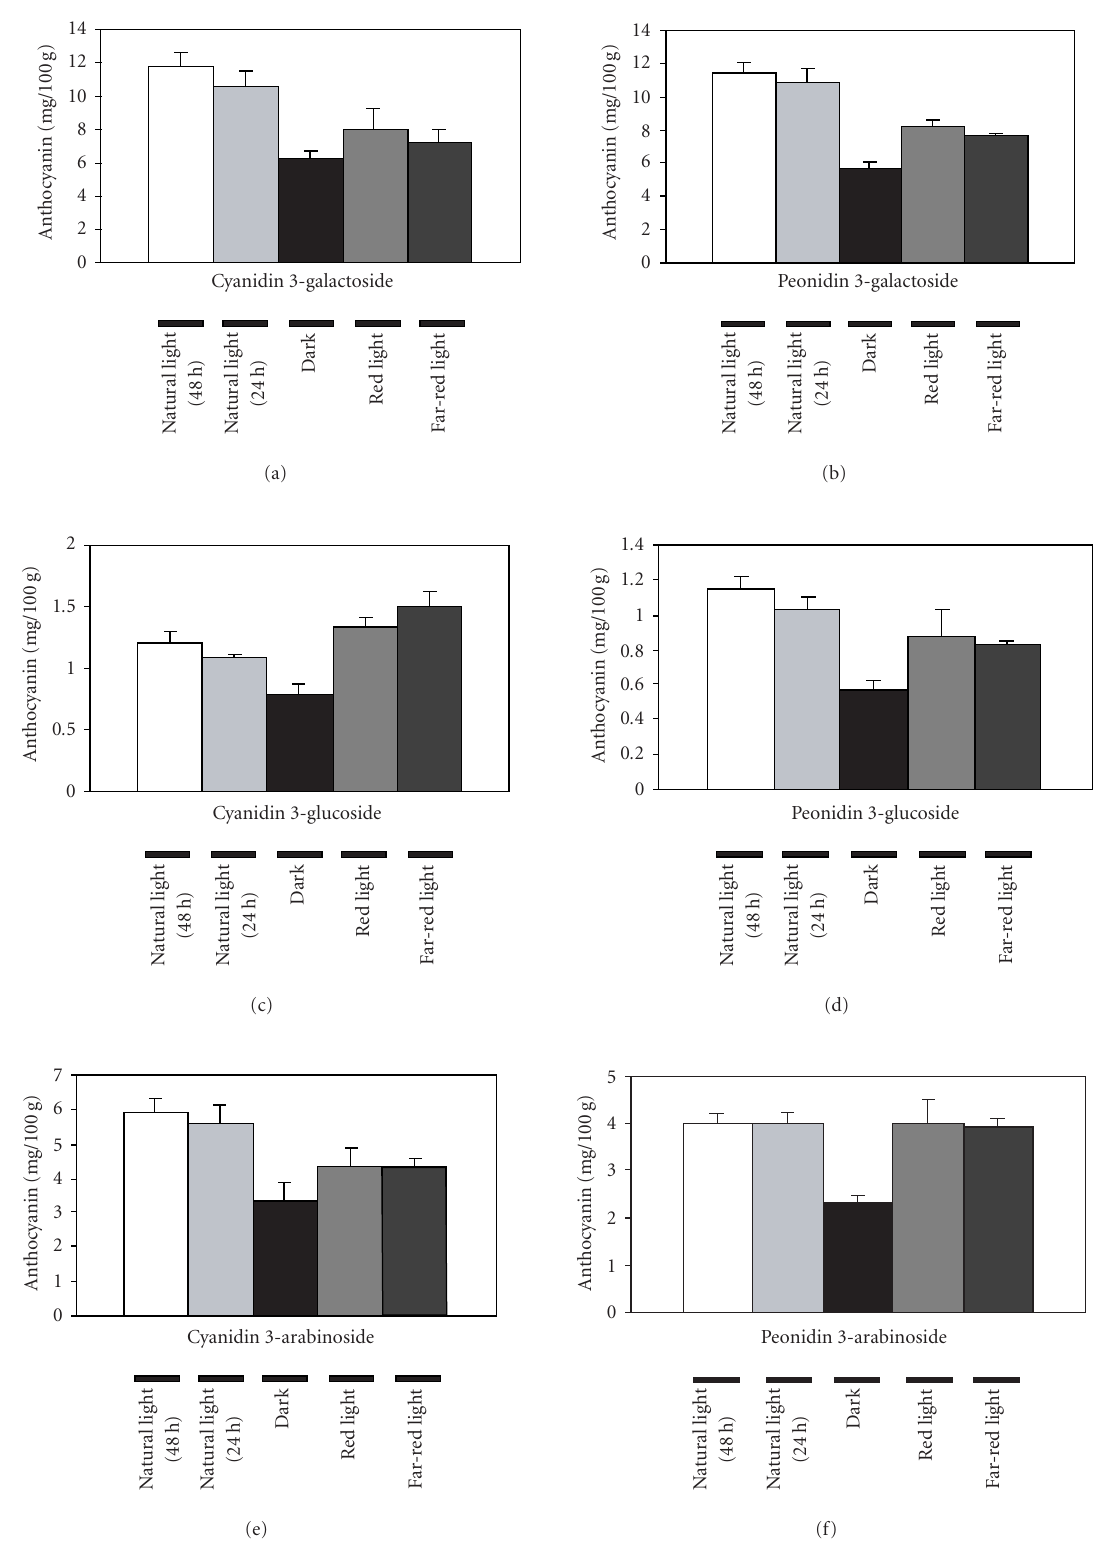
Figure 1. E ff ect of light on individual anthocyanin levels in submerged, harvested cranberry fruit. Cranberries were exposed to di ff erent light conditions and individual anthocyanin content was analyzed. Di ff erent light conditions, natural light (48h), natural light (24h), dark, red light, and far-red light, are indicated in the bottom. Values are mean from triplets with standard error